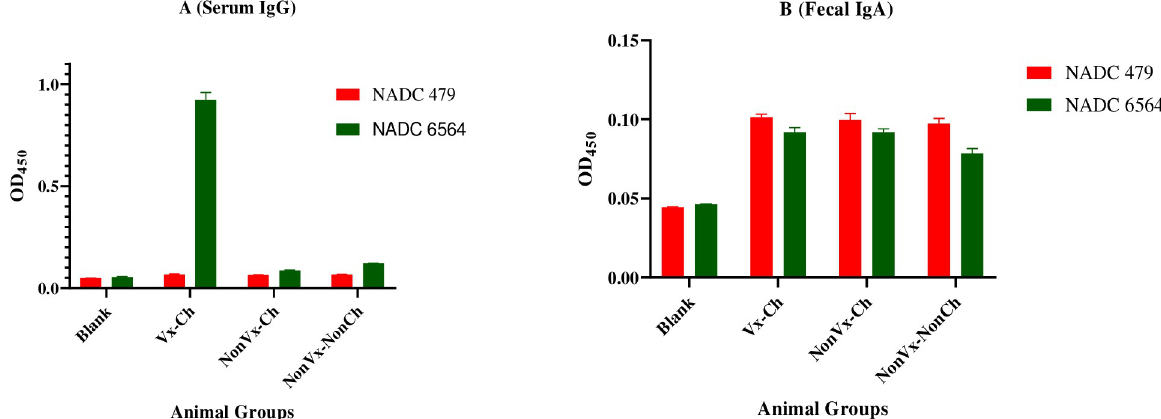
Fig 6. Vaccination induced E . coli O157:H7-specific serum IgG but not E . coli O157:H7-specifc fecal IgA. (A) Relative amounts of serum IgG determined by reacting 10 − 3 -fold dilution of pooled sera representing Vx-Ch, NonVx-Ch, and NonVx-NonCh groups of calves to the commensal E . coli NADC 479 (red bar) and the E . coli O157:H7 challenge strain NADC 6564 (green bar). (B) Bar plot showing specificity of fecal IgA determined by reacting 10-fold diluted, pooled fecal extracts from Vx-Ch, NonVx-Ch, and NonVx-Ch animals to commensal strain NADC 479 (red bars) and E . coli O157:H7 challenge strain NADC 6564 (green bars). Serum IgG and fecal IgA levels are represented as Mean ± SD (shown as bars) of three replicate wells of the pooled serum or fecal samples. Statistical analysis was performed using one way-ANOVA with multiple comparison of means.